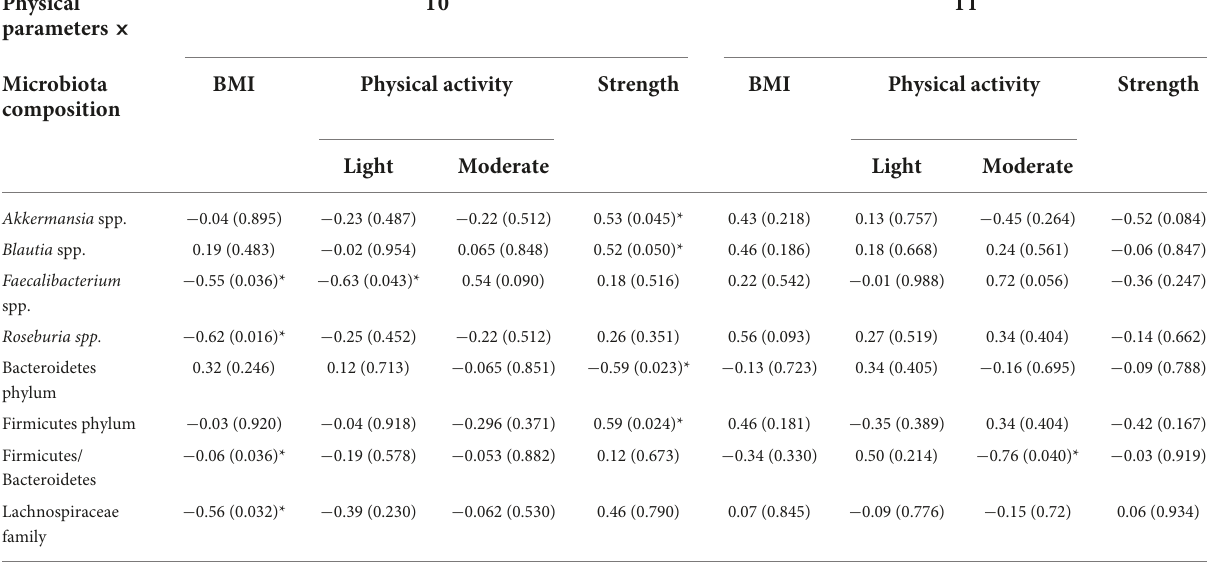
TABLE 4 Associations of BMI, physical activity, strength, and microbiota composition by Spearman correlations analysis before (T0) and 6 months of physical distancing (T1). Physical T0 T1 parameters × Microbiota BMI Physical activity Strength BMI Physical activity composition